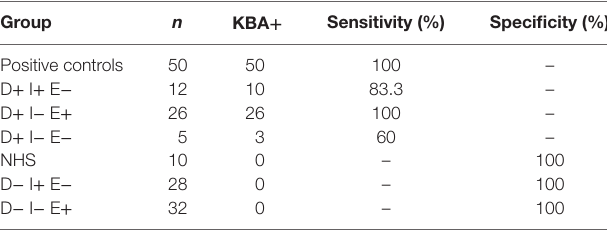
TaBle 3 | Values of sensitivity and specificity calculated for positive and negative controls, biopsy proven pemphigus patients and negative DIF patients groups. group n KBa + sensitivity (%) specificity (%) Positive controls